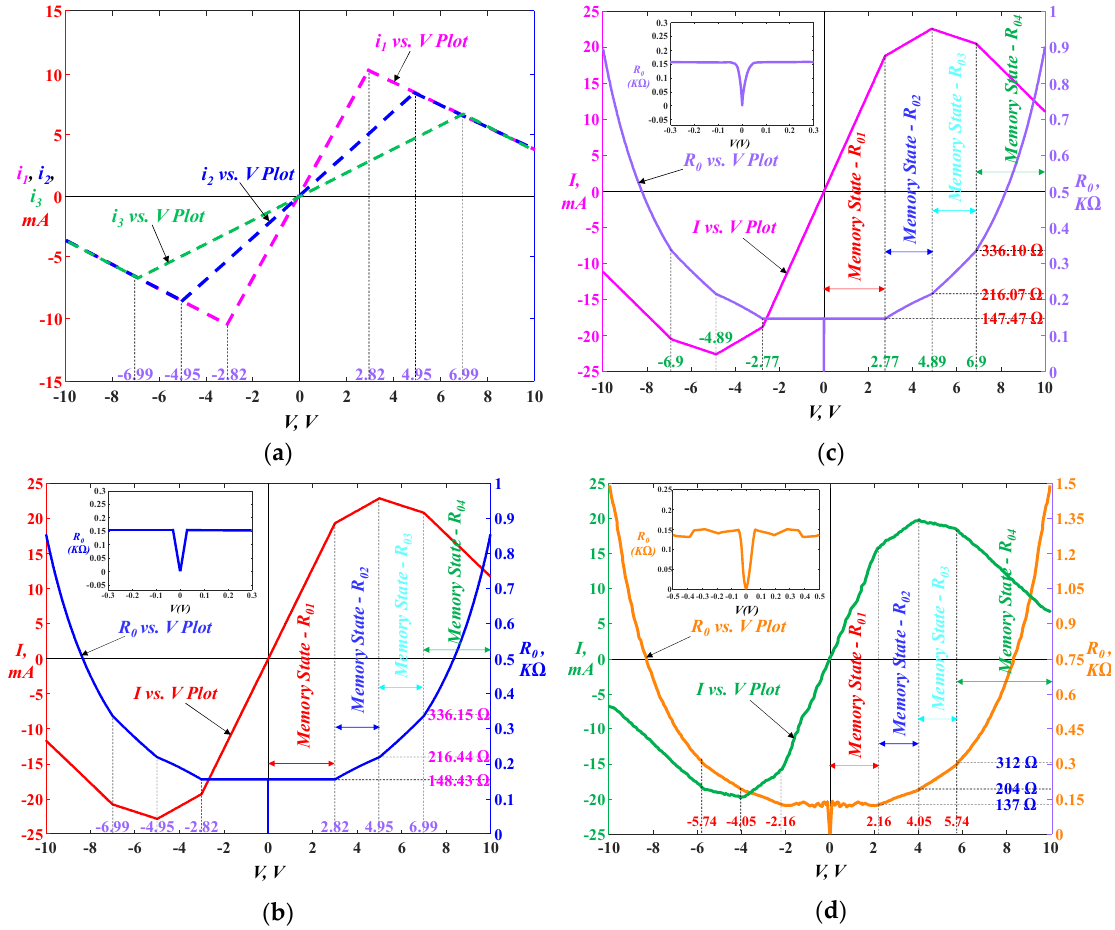
Figure 10. ( a ) DC voltage V vs. current i 1 , i 2 , and i 3 diagram, ( b ) I vs. V and R 0 vs. V plot of mathematical model, ( c ) I vs. V and R 0 vs. V plot of spice circuit simulation, and ( d ) I vs. V and R 0 vs. V plot of the actual circuit implementation of the active and locally active resistor of the 6-lobe CCM emulator.